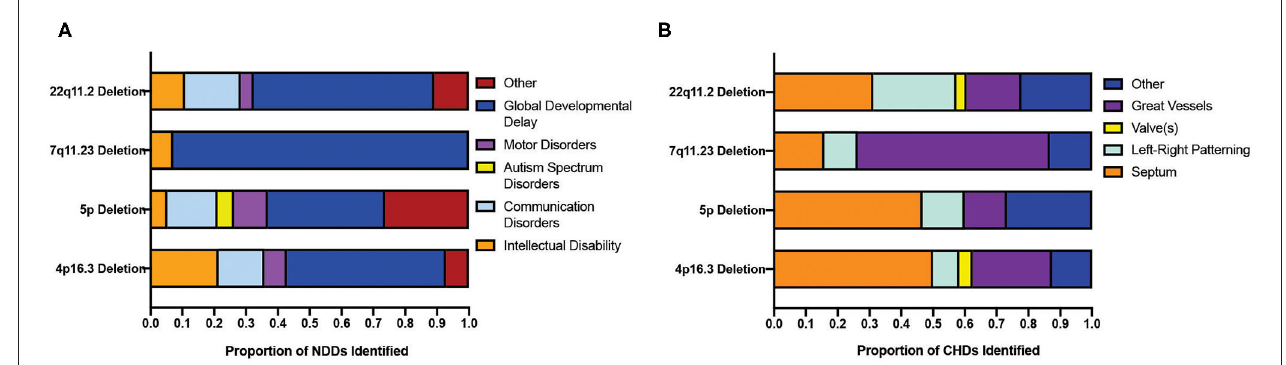
FIGURE 4 | Distribution of sub-clinical phenotypes of neurodevelopmental and congenital disorders across CNVs displaying a significant co-morbidity. (A) Distribution of the clinical phenotypes of NDDs across four CNVs showing the highest co-morbidity of NDD and CHDs. (B) Distribution of the clinical phenotypes of CHDs in the top four CNV populations showing the highest co-morbidity of NDD and CHD. CNV, copy number variant; CHD, congenital heart disorder; NDD, neurodevelopmental disorder.